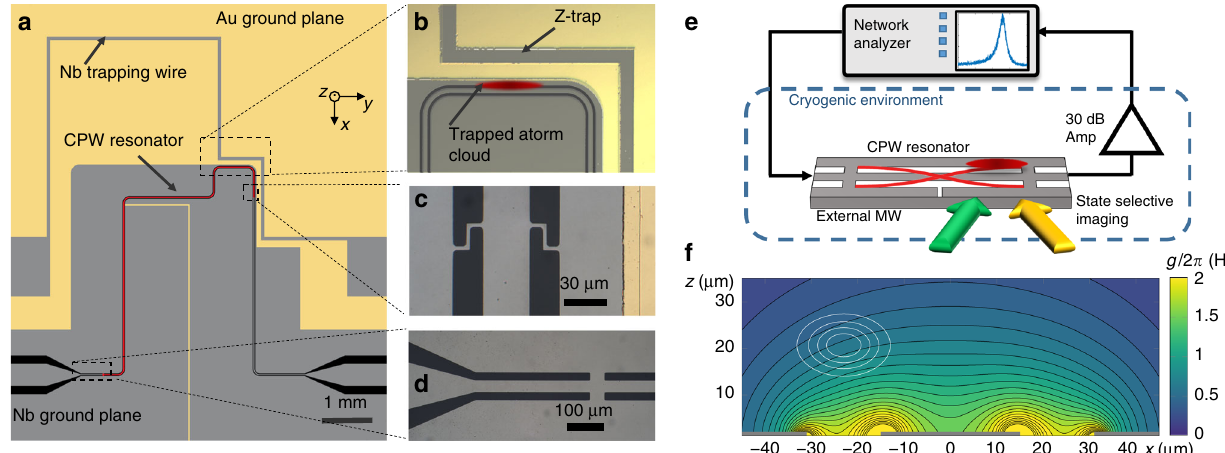
Fig. 1 A superconducting atom chip for coupling ultracold atoms to a coplanar resonator. a Schematic top view of the superconducting atom chip, comprising a Z-shaped trapping wire and a coplanar microwave resonator (center conductor marked in red). Parts of the niobium ground planes have been replaced by gold to circumvent the Meissner effect and facilitate magnetic trapping. The slit in the lower ground plane prevents the formation of a closed superconducting loop. b Optical microscope image of the trapping region with the position of the atoms trapped close to the antinode of the resonator. During the measurements, trapping is purely provided by persistent supercurrents around the upper cavity gap and external fi elds. c Microscope image of the coupling inductances at the output of the resonator and d at the input of the resonator. e Scheme of the measurement setup. Atoms are coupled to a driven coplanar waveguide resonator and detected by state-selective absorption imaging. For Ramsey experiments in the dispersive regime, additional external microwave fi elds are used to manipulate the atoms. f Simulated coupling strength g /2 π (Hz) between a single ground-state atom and a single photon in the cavity, resonant to the | 1, − 1 〉 → | 2, 0 〉 transition. The white lines indicate positions of equal density for an atomic cloud of temperature T at = 800 nK in the trap, corresponding to 20, 40, 60, and 80% of the density in the center